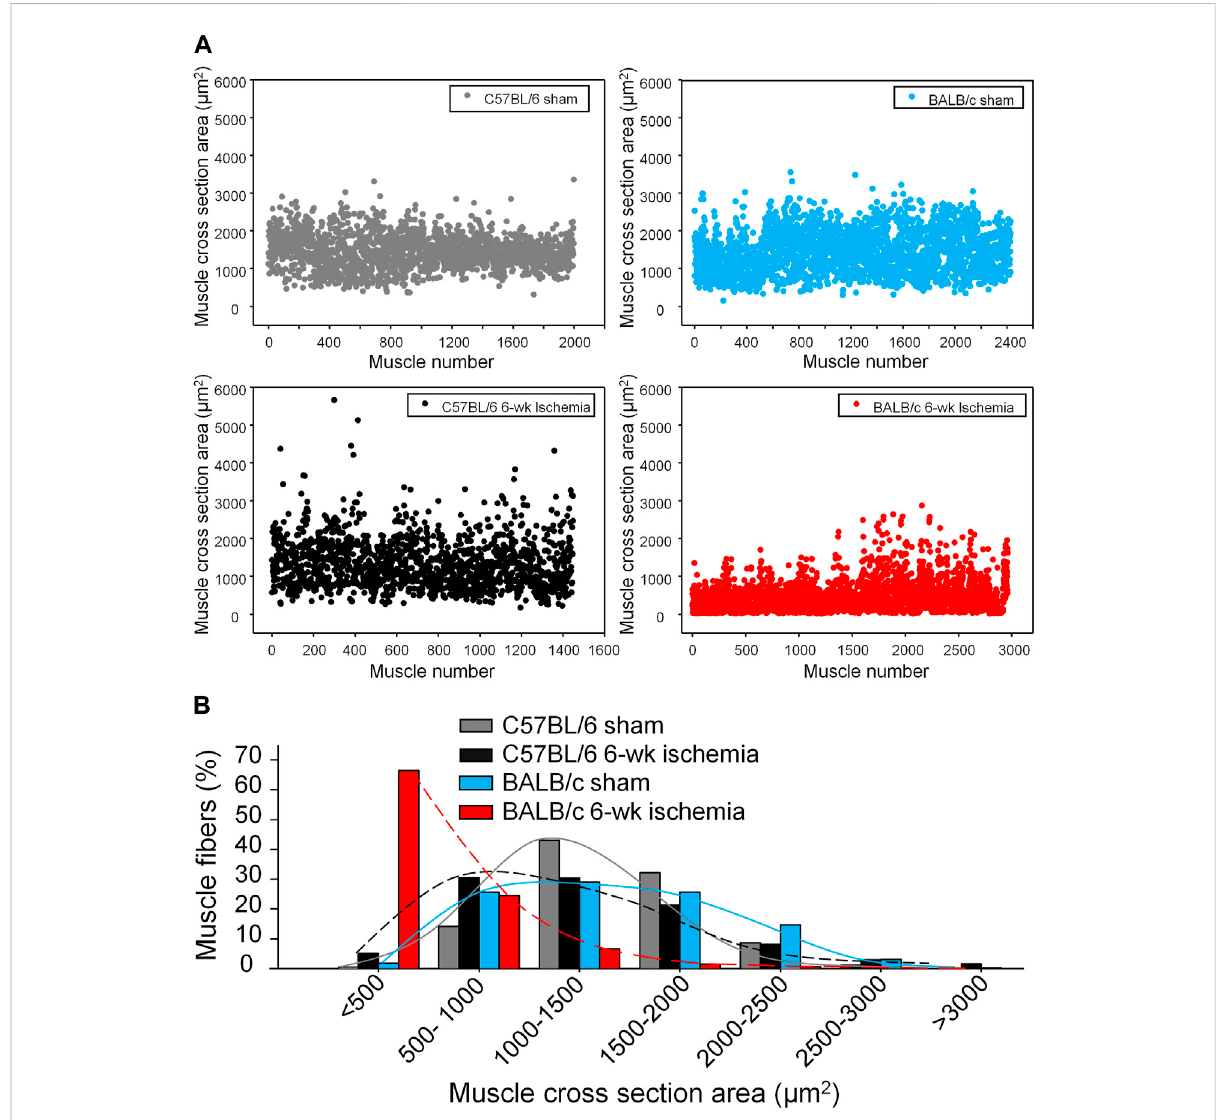
FIGURE 3 Thedistributionofmyo fi bersizesinallexperimentalgroups. (A) ,dotplotsforthemyo fi bernumberineachsizerange. (B) ,thepercentageofthe myo fi ber number in each size range to total number of myo fi